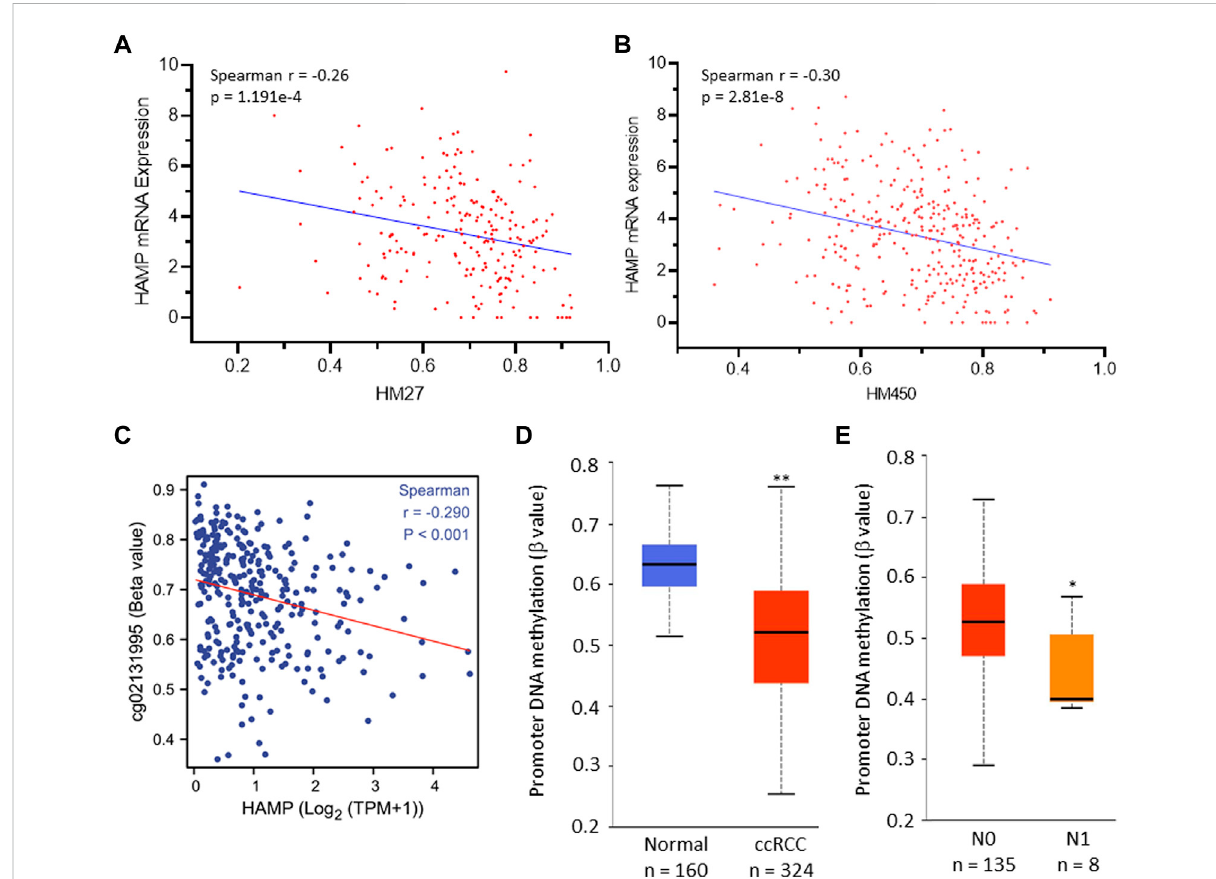
FIGURE 2 HAMP upregulation is correlated with HAMP gene hypomethylation in ccRCC tissues. (A,B) Spearman correlation coef fi cient was analyzed between HAMP gene promoter methylation and HAMP expression [RNA-seq V2 RSEM, log 2 (value +1)] using the TCGA PanCancer RNA-seq dataset derived from Illumina In fi nium Human Methylation BeadChips HM27 (217 ccRCC cases) and HM450 (319 ccRCC cases) platforms. (C) Spearman correlation coef fi cient was analyzed between HAMP gene methylation and HAMP expression. The probe cg02131995 covers the region